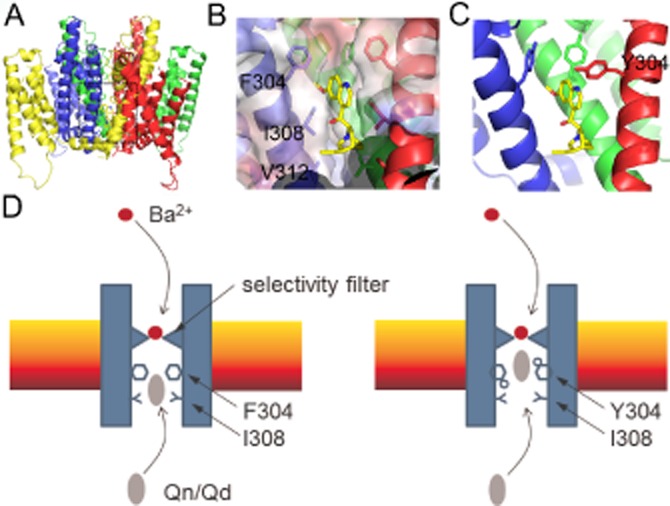
Molecular modelling of mSlo3 and inhibition by quinidine. (A) Homology model of the transmembrane regions S1 to S6 of mSlo3; the structure is shown as a side-on view from the membrane, with the extracellular space above the protein. Each subunit of the tetrameric structure is coloured differently for clarity and only side chains F304, I308 and V312 are shown in stick format. (B) A zoomed-in view of the proposed quinidine-binding site, with subunits labelled blue, red and green, (the fourth subunit has been removed for clarity). The residues which make up the hydrophobic binding pocket (F304, I308 and V312) are shown in stick format and the surface shows the hydrophobic isoelectric character. (C) The same view as in (B) but with tyrosine replacing F304, showing the proximity of the terminal oxygen to the methoxyquinoline group of quinidine where hydrogen bonding could occur. In both (B) and (C), the quinidine molecule is shown in stick format and coloured, yellow, blue and red for carbon, nitrogen and oxygen respectively. (D) Proposed mechanisms for the inhibition induced by Ba2+ ions and quinine or quinidine (Qn/Qd): Ba2+ enters the pore from the extracellular side and blocks at the selectivity filter; quinine and quinidine cross the membrane and block from the intracellular side at a site involving F304 and I308 (left). In the F304Y mutation (right), the Ba2+ block is unaffected, but a deeper binding site is available for quinine and quinidine entering the pore from the intracellular side. Possible mechanisms are discussed in the main text.